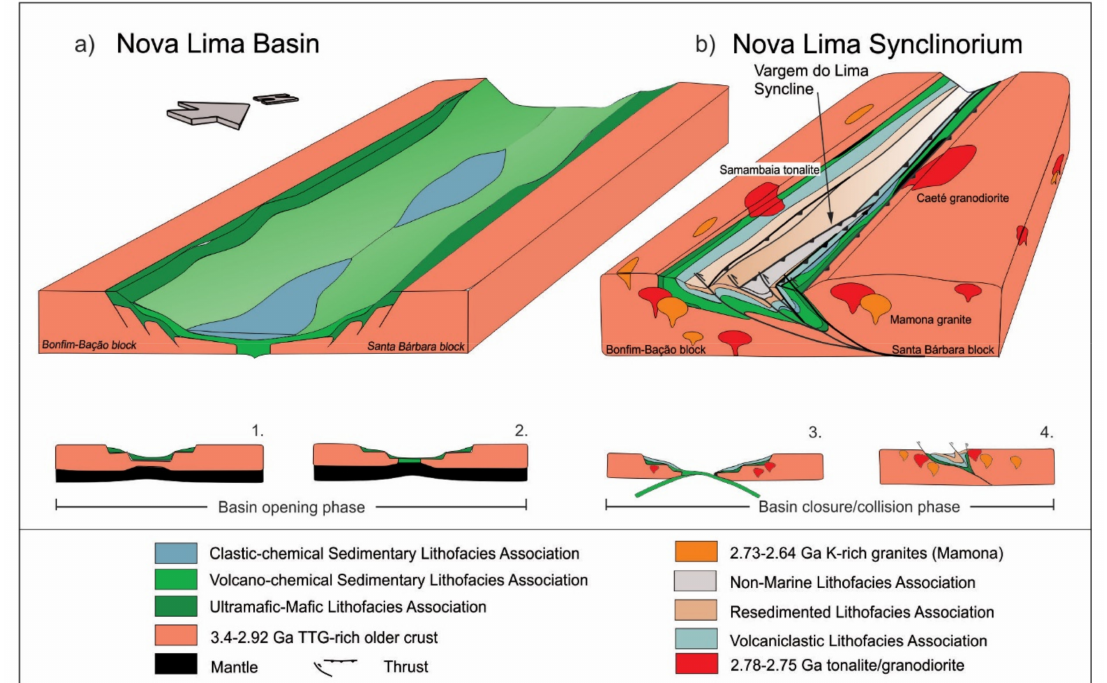
Figure 9. A proposed model for the tectonic evolution of the Rio das Velhas greenstone belt. ( a ) Nova Lima basin: developed in response to a rifting of sialic crust caused by a mantle plume (1); basin enlargement and opening of an ocean floor, sedimentation of the clasto-chemical association at the end of the extension (2). ( b ) Nova Lima synclinorium: due to basin inversion, felsic volcanism, volcaniclastic-epiclastic sedimentation and syn-kinematic magmatism along rift margins (3); advanced inversion and collision, closure of Nova Lima back-arc basin and development of the syn-thrusting Maquin é foreland basin (4). (1–4), modified from